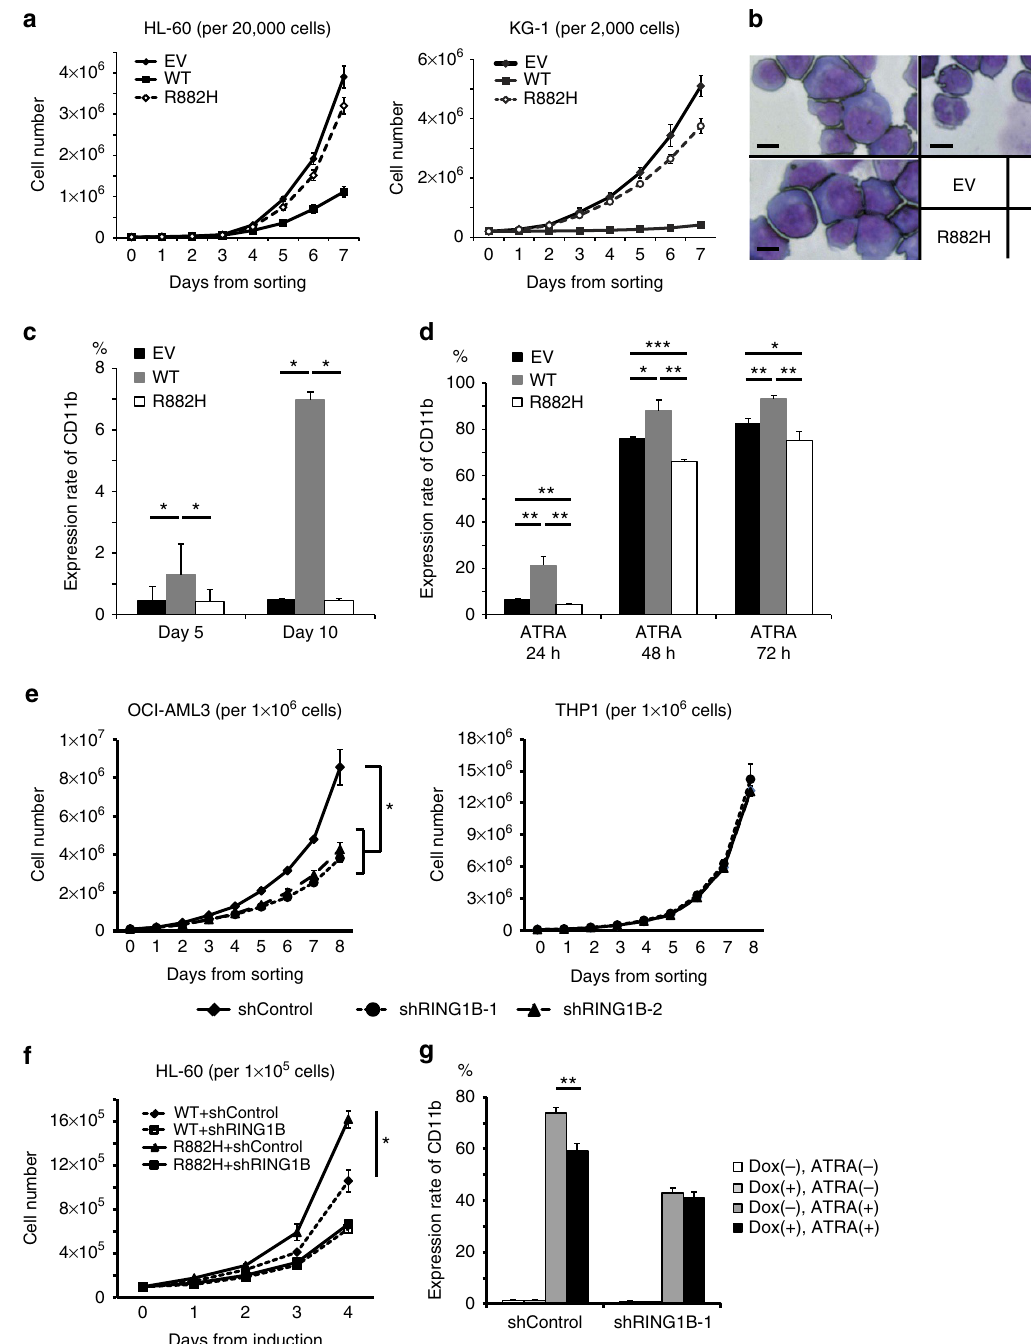
Figure 6 | DNMT3A R882 mutation reduces sensitivity to ATRA-induced differentiation in AML cells, which is abrogated by suppression of PRC1. ( a ) Growth curve of HL-60 (left) or KG-1 (right) cells transduced with EV, WTor R882H. ( N ¼ 3 replicate experiments.) ( b ) Typical morphology of HL-60 cells transduced with EV, WTor R882H. Scale bar, 10 m m. ( c ) Cumulative data of CD11b positivity rate at 5 and 10 days after transduction with EV-, WT- or R882H in HL-60 cells; N ¼ 3 replicate experiments. P values were calculated using two-tailed unpaired t -test. ( d ) Cumulative data of CD11b positivity rate 24, 48 and 72h after transduction with each vectors and administration of ATRA (1 m M); N ¼ 3 replicate experiments. P values were calculated using two- tailed unpaired t -test. ( e ) Growth curve of OCI-AML3 (left) and THP1 (right) cells transduced with shControl or shRING1B; N ¼ 3 replicate experiments. P values were calculated using two-tailed unpaired t -test and the differences between groups, as indicated, were all statistically significant at day 5–8 after sorting. ( f ) Growth curve of HL-60 cells transduced with Dox-inducible WTor R882H, and shControl or shRING1B; N ¼ 3 replicate experiments. P values were calculated using two-tailed unpaired t -test and the differences between groups, as indicated, were statistically significant at day 3 and 4 after induction. ( g ) Cumulative data of CD11b positivity rate 48h after Dox-induced transgene expression and administration of ATRA (1 m M) or EtOH; N ¼ 3 replicate experiments. P values were calculated using two-tailed unpaired t -test. AML, acute myeloid leukaemia; Dox, doxycycline; EV, empty vector; PRC1, polycomb repressive complex1; WT, wild type. Data are mean ± s.d. values. * P o 0.05, ** P o 0.01, *** P o 0.001.